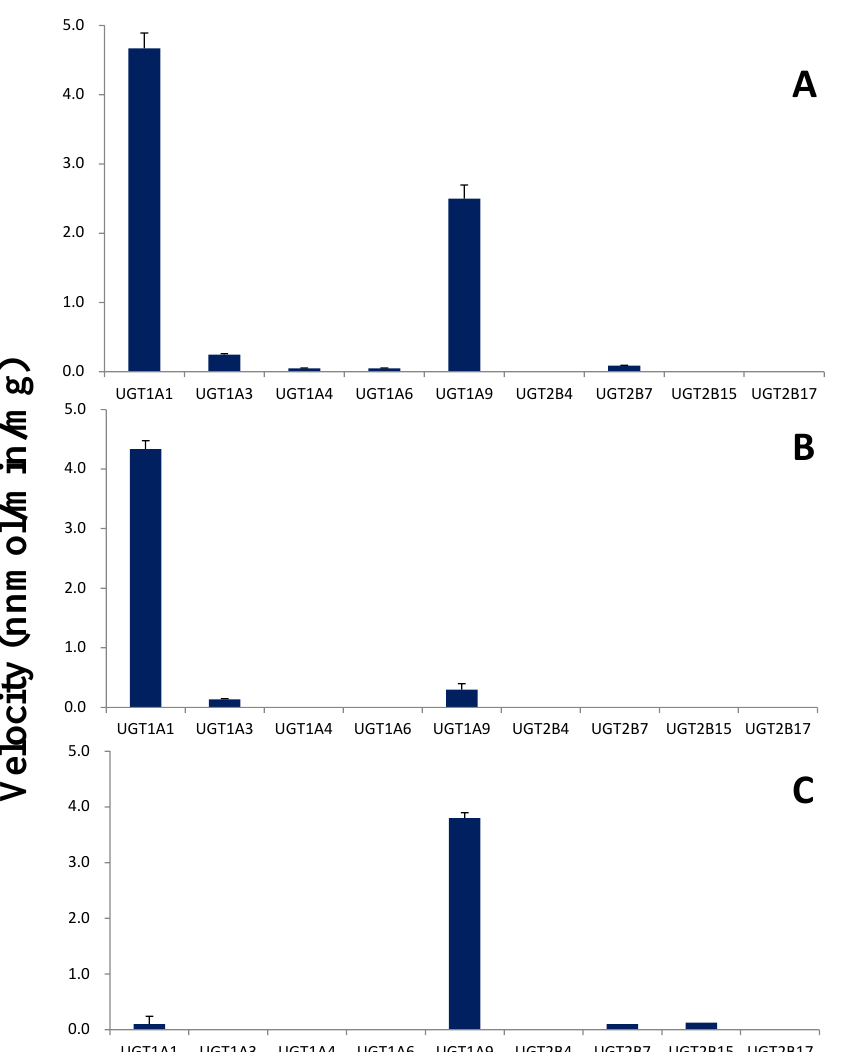
Figure 5. Screening of glucuronidation metabolism of tectorigenin and irigenin with eight recombi- nant enzymes ( n = 3; data represent the mean ± SE). ( A ) Velocity for the formation of the metabolite of tectorigenin; ( B ) velocity for the formation of metabolite 1 of irigenin; ( C ) velocity for the formation of metabolite 2 of